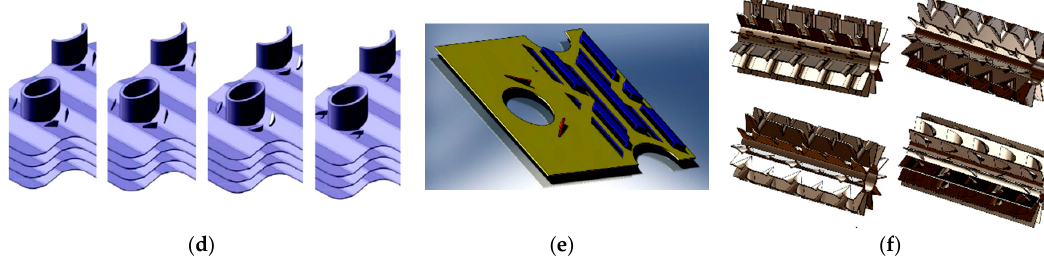
Figure 2. Recently proposed vortex generators (VGs). ( a ) Annular winglet and wave-element VGs [6,9,15,16]. ( b ) V-deployed VG array [17]. ( c ) Curved winglet VGs with or without punched holes [18,19]. ( d ) Wavy fin and oval-tube bank with mounted VGs [20,21]. ( e ) Composite fin with VGs and slit fin [22]. ( f ) Longitudinally finned tubes by Stehlík et al. [10].